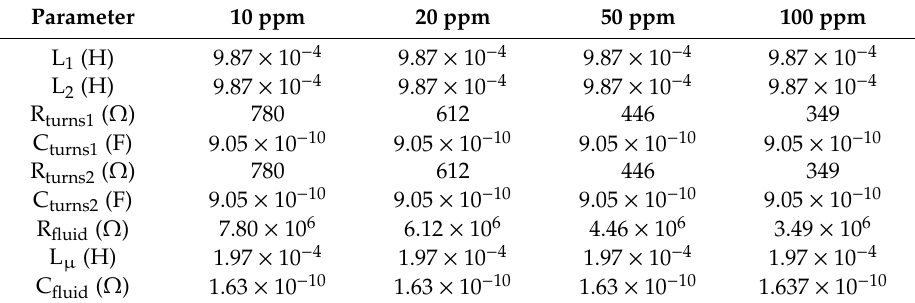
Table 2. Simulation model, parameters’ evolution when the salt concentration in water varies.